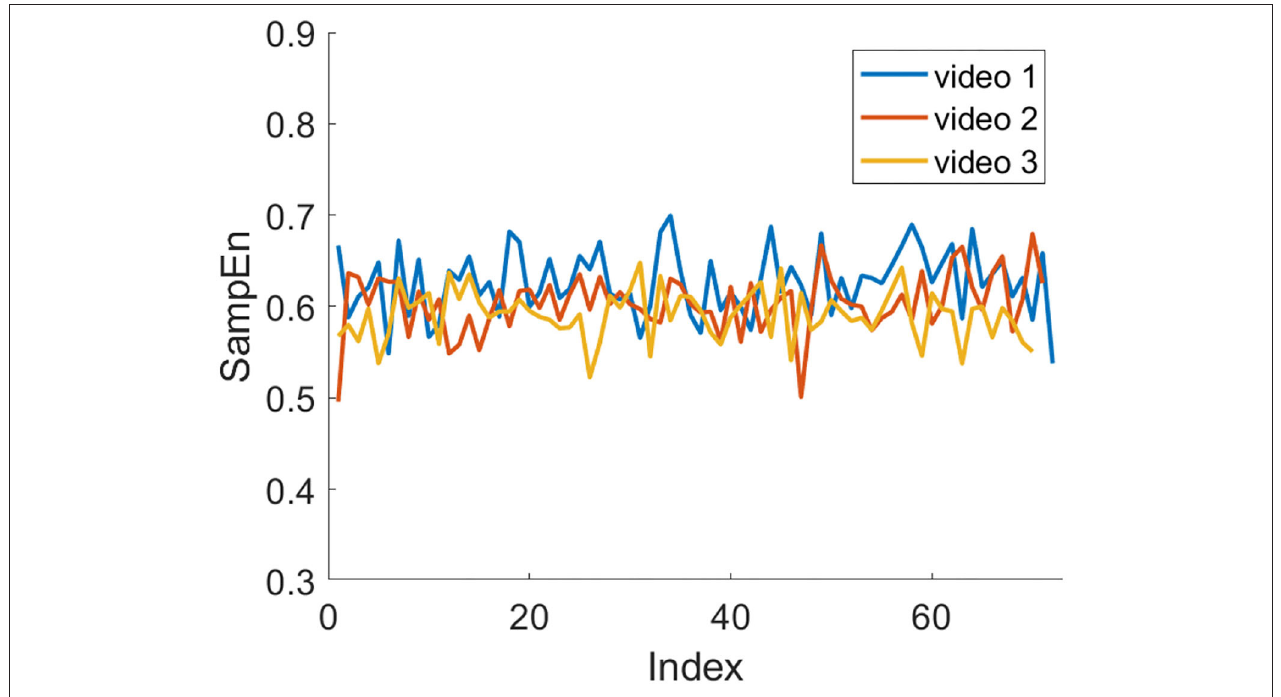
FIGURE 9 | Average SampEn of three videos in session 1 over time.